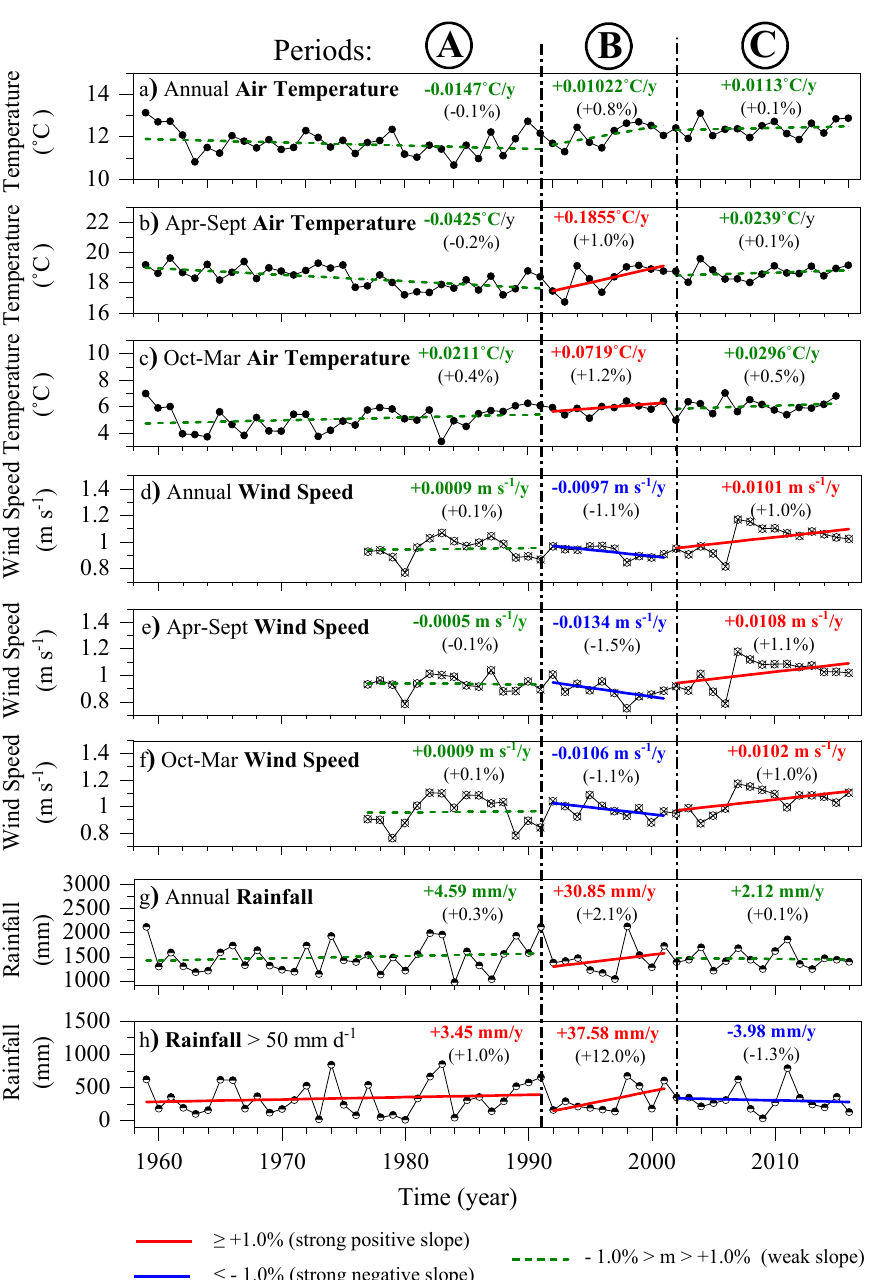
Figure 3. Average air temperature ( a – c ), wind speed ( d – f ) and basin-averaged rainfall ( g , h ). Colored straight lines are linear fit for each period, with colored texts as slopes, while values in parentheses are slope percentages (slope value/average value for that period × 100).